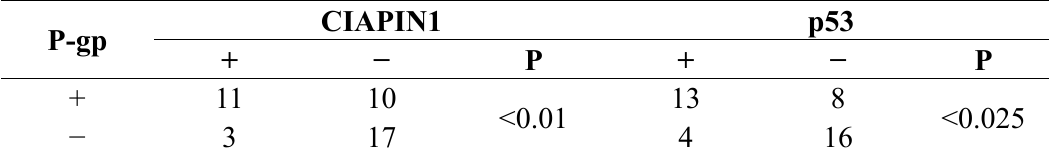
Table 1. Relationship among the expression of P-gp, CIAPIN1 and P53 in breast cancer tissues.